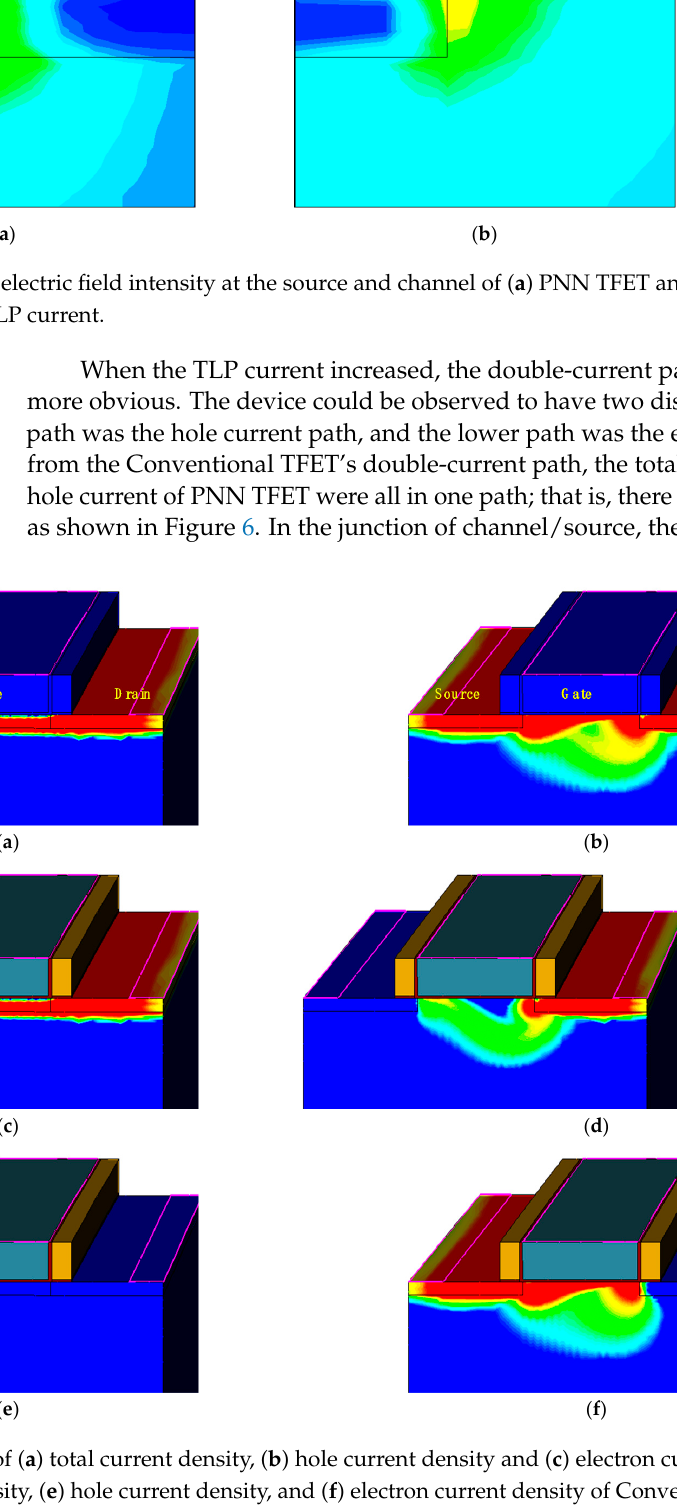
( b ) Figure 7. Contour plot of potential of ( a ) SiGe PNN TFET and ( b ) Conventional TFET. 5. Optimization of SiGe S/D PNN TFET Device Parameters Under an ESD event, the Joule heat is the main heat component in the device, and it can be expressed as in reference [29]. H Joule =H P +H n = J P2 pq μ p + J n2 nq μ n , (2) Where H is heat, J is current density, μ is mobility, and the subindices n and p are electrons and holes, respectively. The joule heat of the hole is higher than the joule heat of